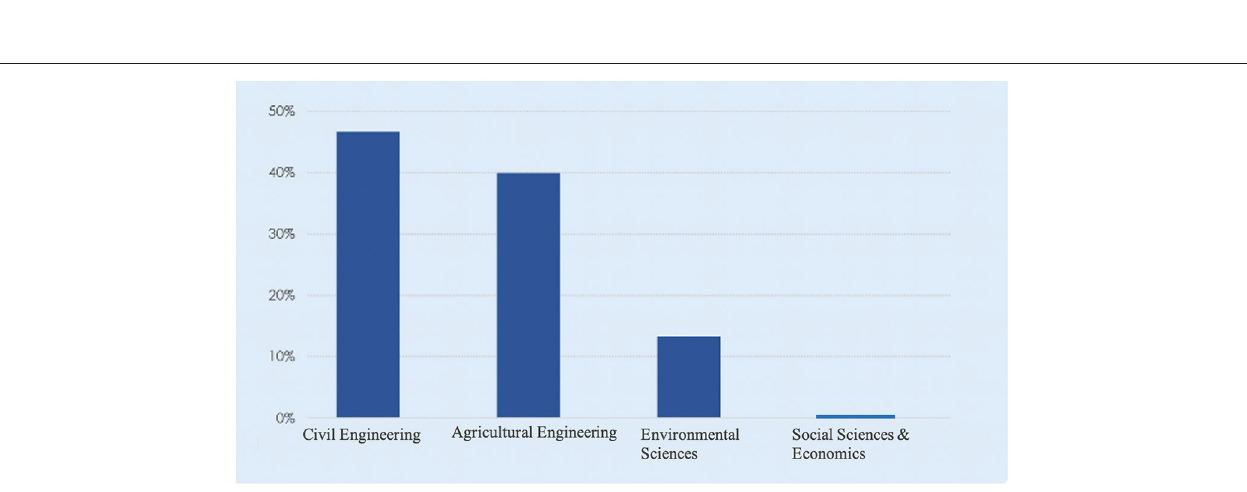
FIGURE 7 | Disciplinary background of experts speaking for water during Iran’s water crisis −